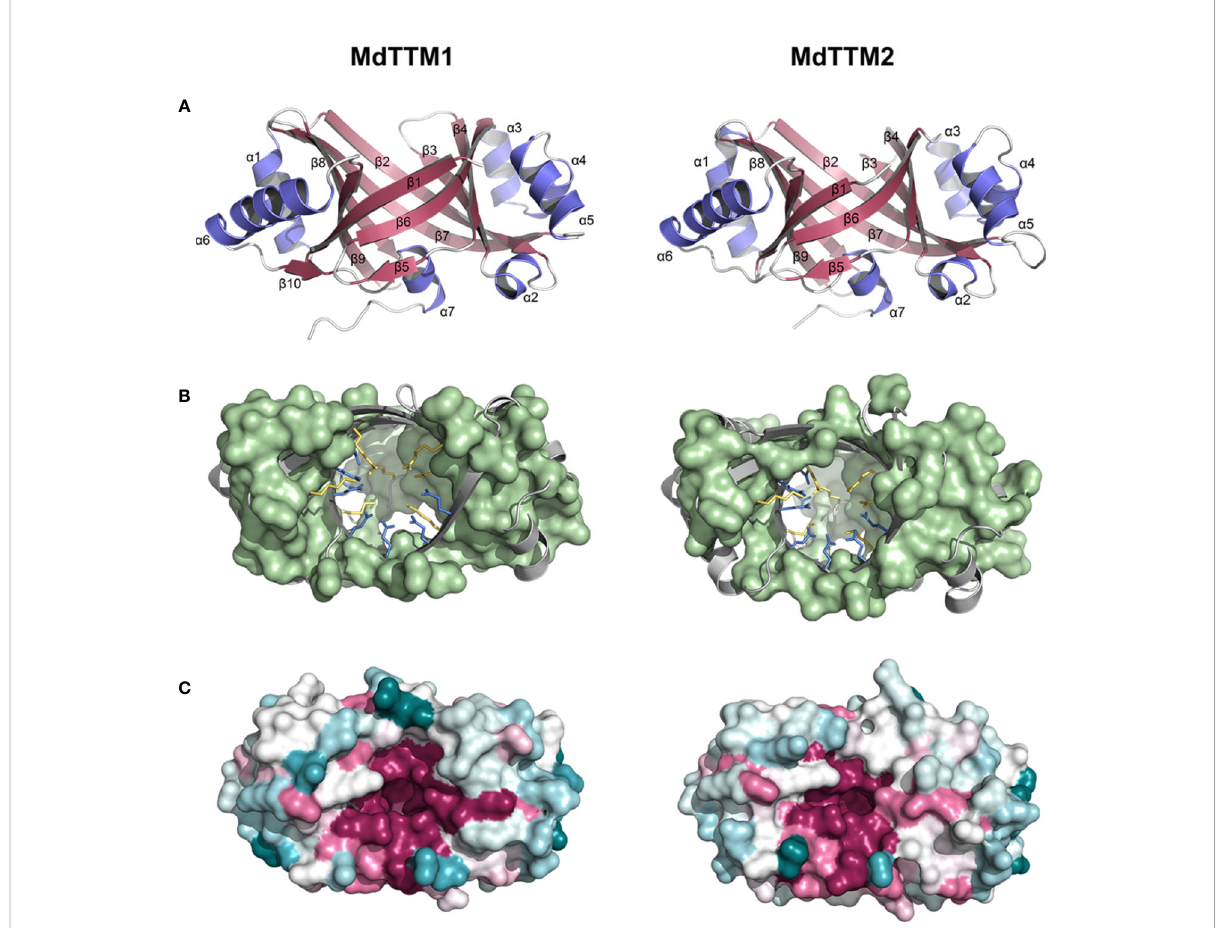
FIGURE 4 Protein prediction analysis of MdTTM1 and MdTTM2. (A) Overall fold view of MdTTM1 and MdTTM2. (B) Basic and acidic residues of the inside tunnel of MdTTM1 and MdTTM2. Basic and acid residues were presented with yellow and cyan sticks, respectively. Hydrophobic residues were presented with a light green surface. (C) Surface models of MdTTM1 and MdTTM2. Different colors represent the conservation level of the proteins. MdTTM1 and MdTTM2 were modeled with AlphaFold 2.0. Conservation analyses were performed on Consurf Server (https://consurf. tau.ac.il/consurf_index.php), and images were created with PyMOL (ver.